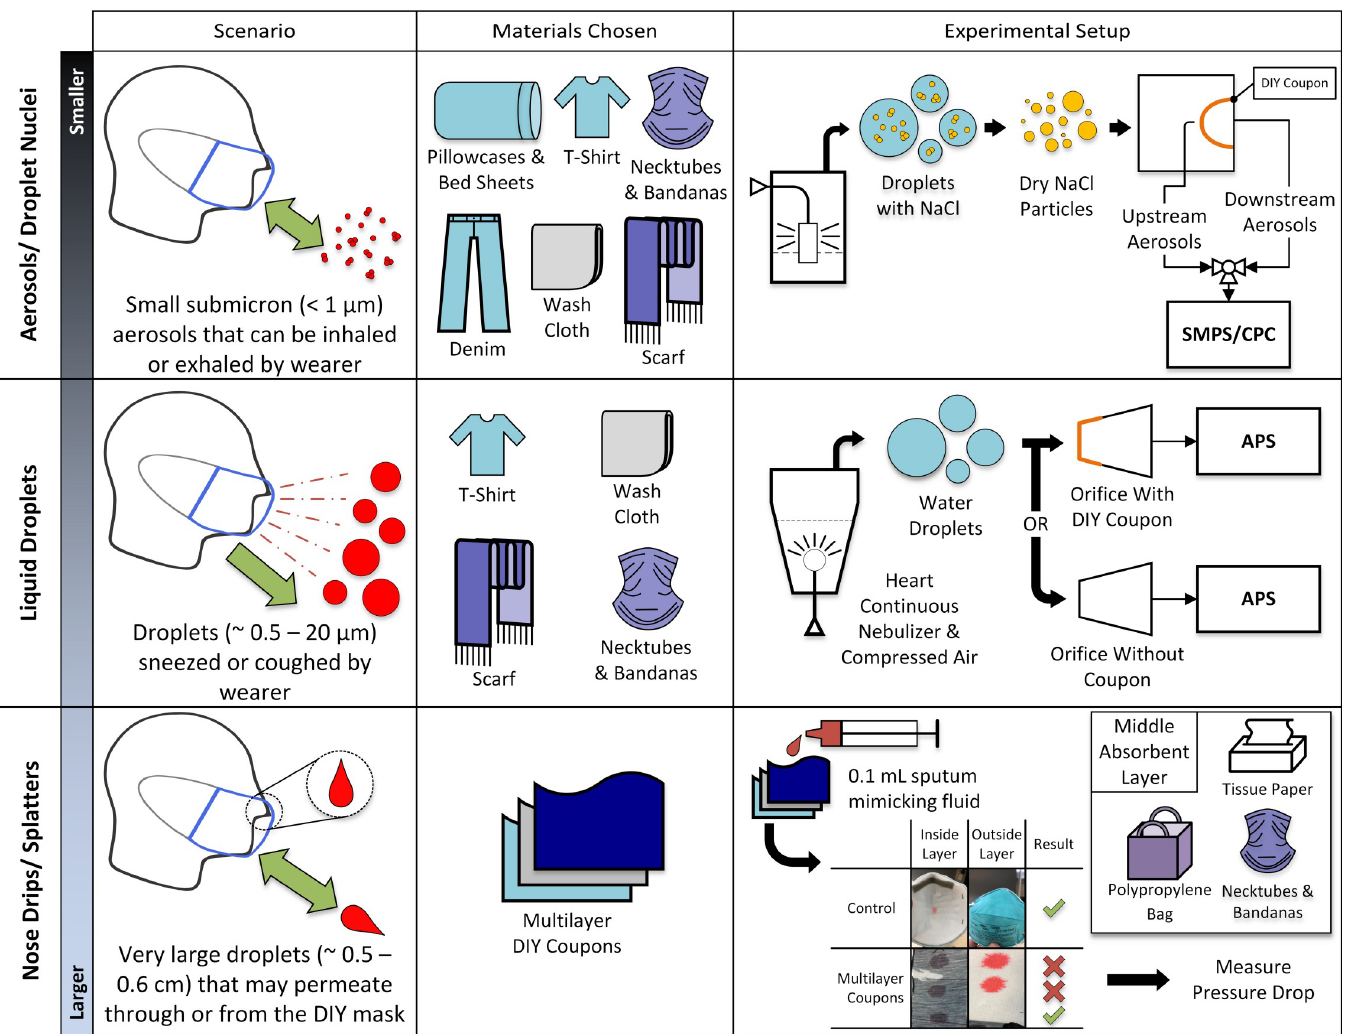
Fig 1. An overview of the three-step methodology. Step 1 : Household material coupons were tested for filtration efficiency and pressure drop at a flow velocity of 9 cm/s using dried, charge conditioned aerosols (Table 1). Step 2 : Select materials were tested against wet water droplets at very high velocities (~ 481 cm/s and 1700 cm/s) (Fig 2). Step 3 : a large volume (0.1 mL) of artificial saliva was deposited on the material surface to investigate the permeability of multilayered DIY coupons (Table 2). SMPS: Scanning Mobility Particle Sizer; CPC: Condensation Particle Counter; APS: Aerodynamic Particle Sizer; DIY coupons: Do-It-Yourself i.e. household material coupons.